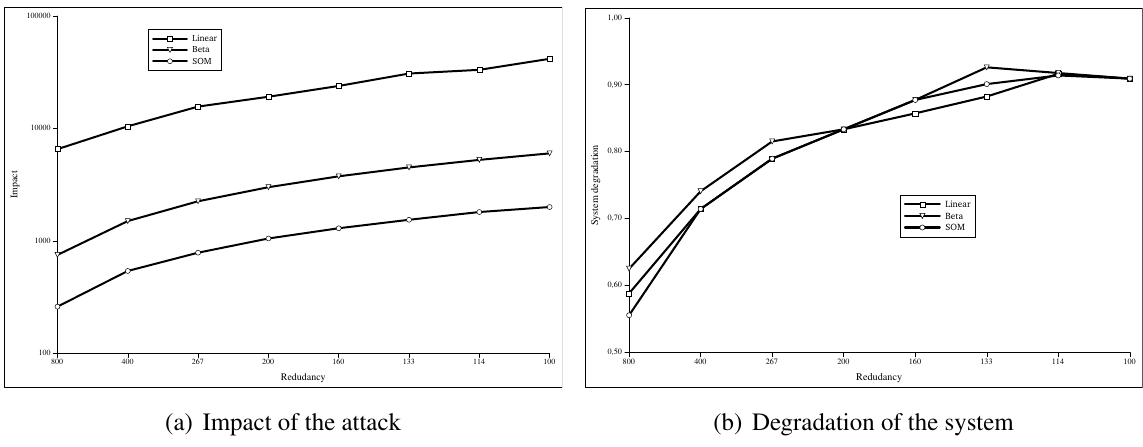
Figure 5. Evolution of the impact of the attack and the based on the sensor node